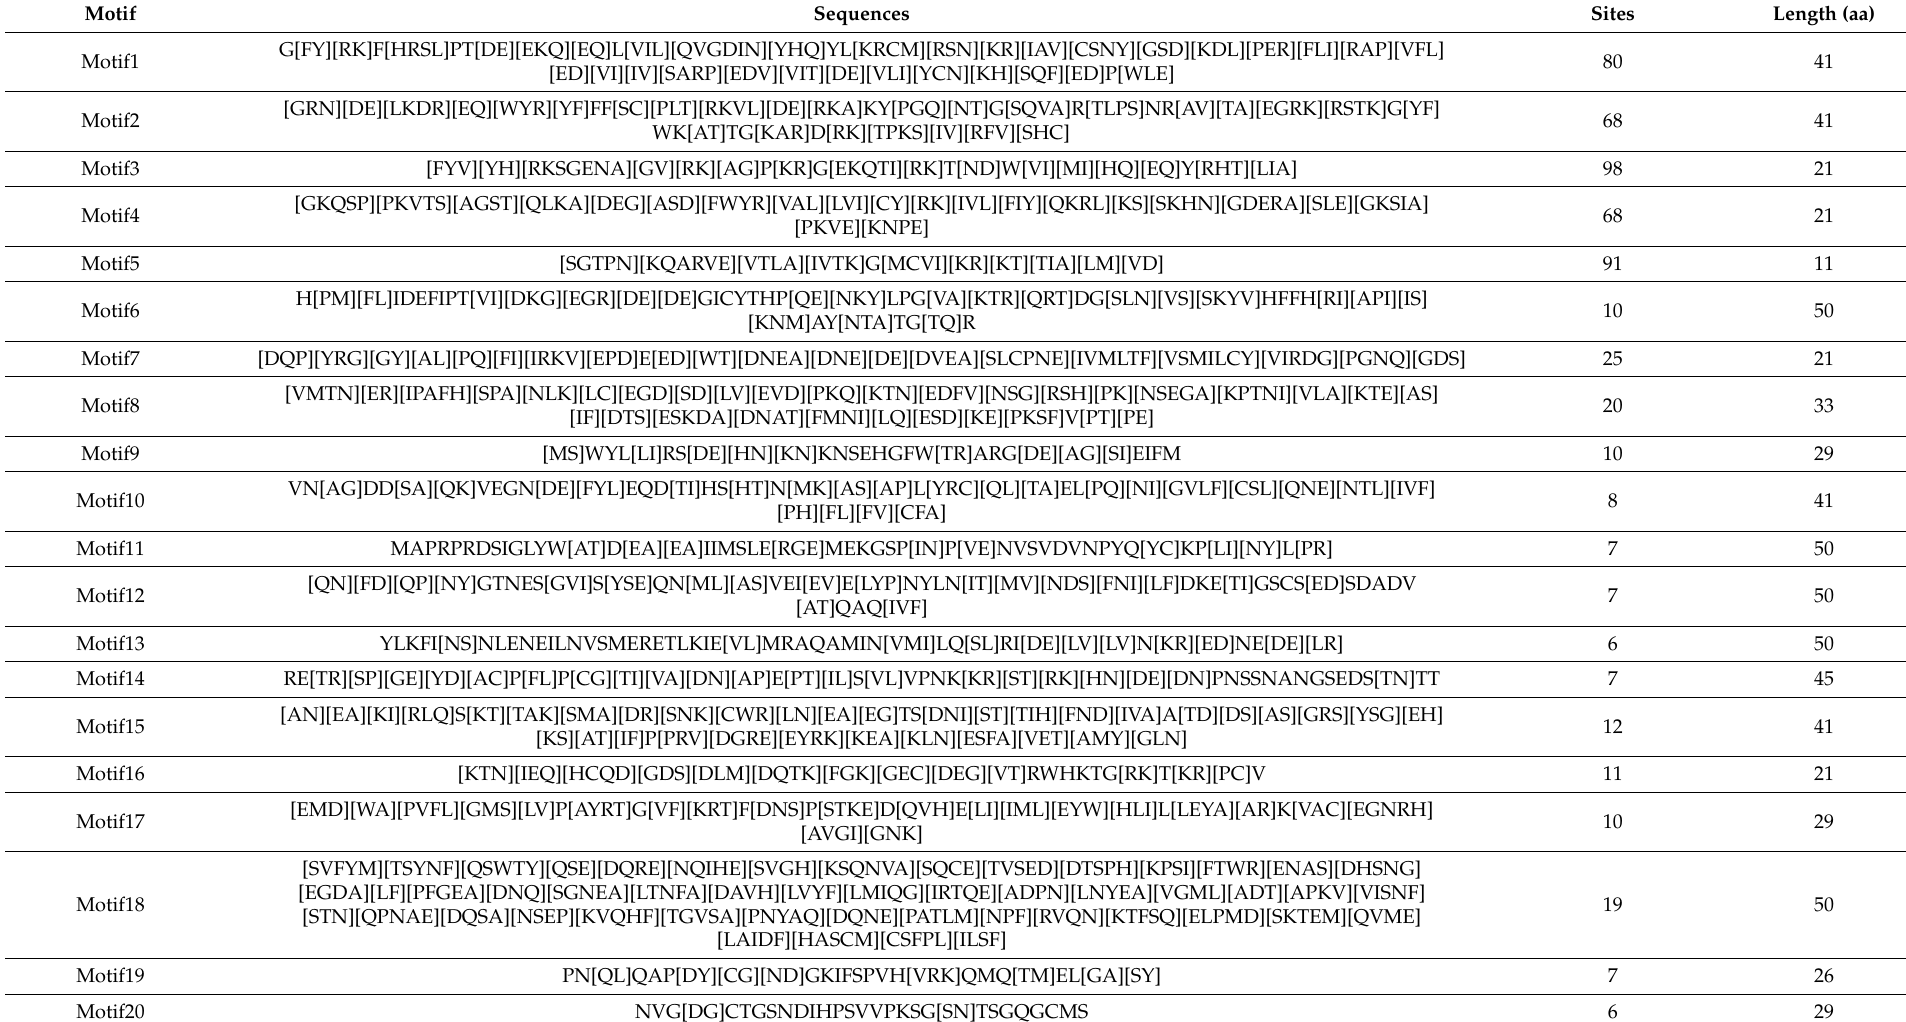
Table 2. Normal expression sequences of 20 motifs identified. Sites represent the time of motif